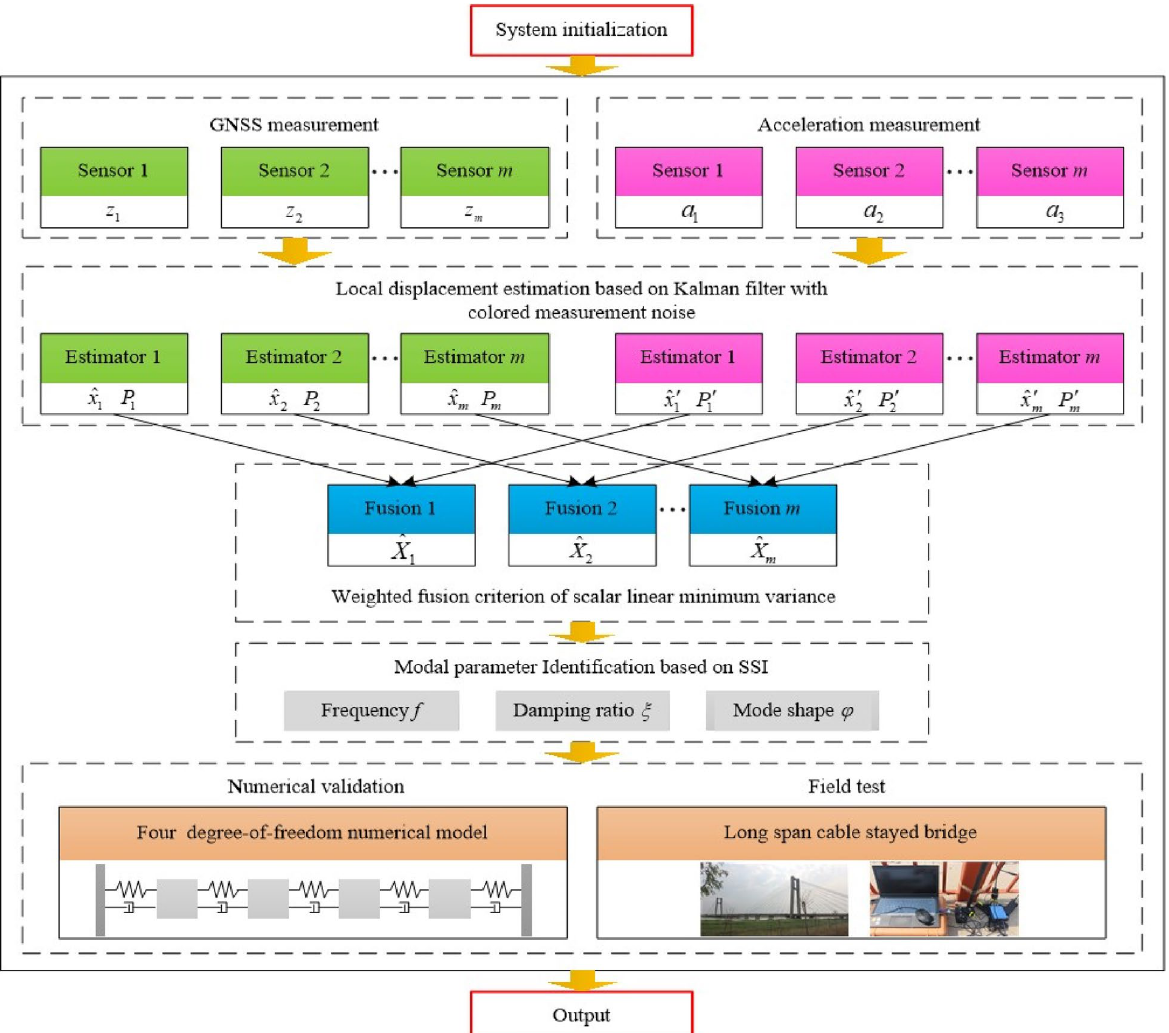
Fig. 1 Flow chart of displacement estimation and operational modal analysis based on data fusion and SSI